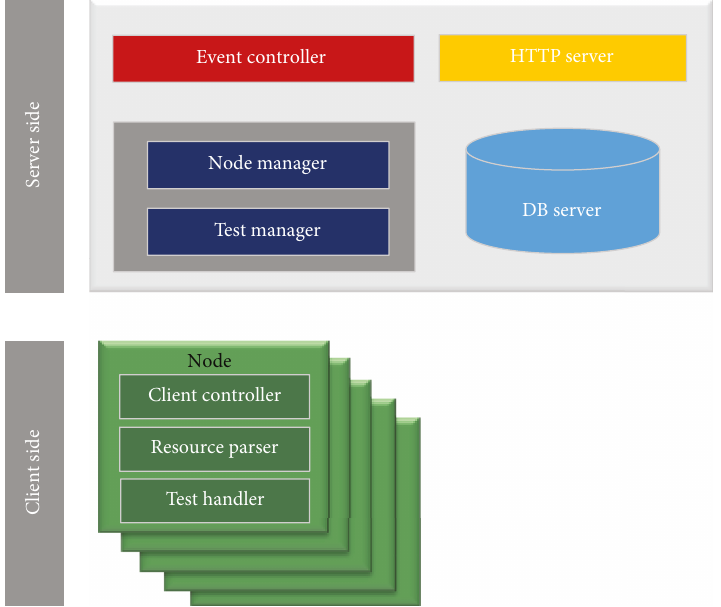
Figure 3: The software architecture of the proposed